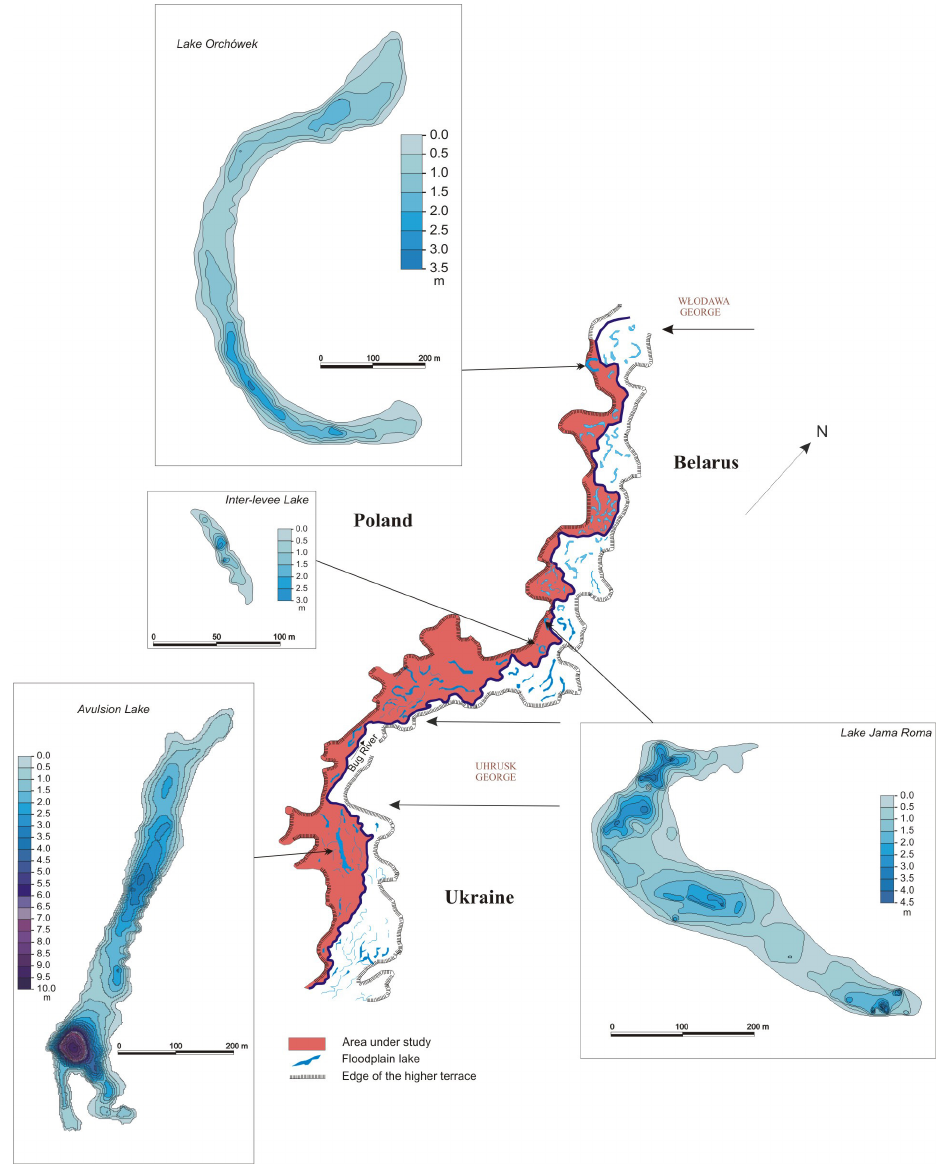
Fig. 2. Location and morphometry of the lakes under